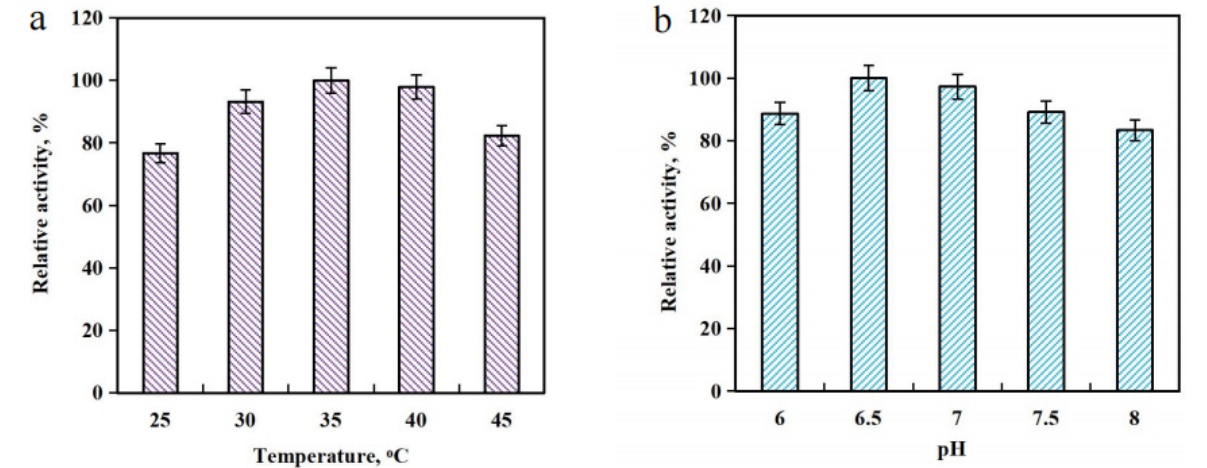
Figure 5. Effects of performance temperature (25–45 °C) ( a ) and medium pH (6.0–8.0) ( b ) on FAL- reducing activity in ChCl:LA–water (30:70, v / v ).